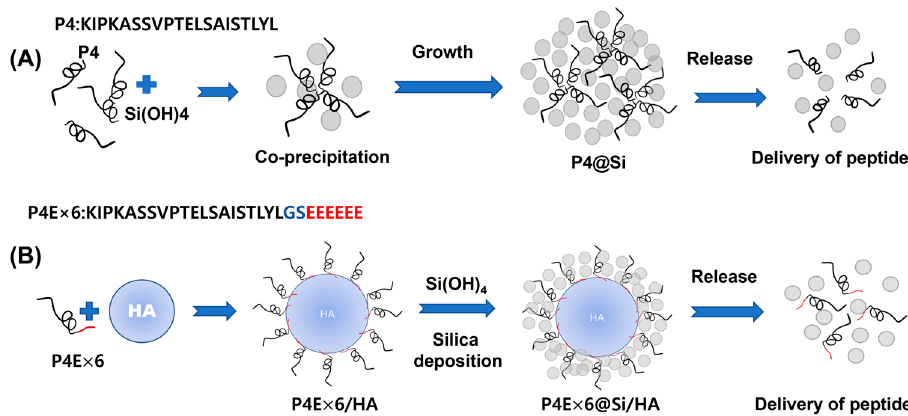
Scheme 1. Self-immobilization of P4 peptide via P4-mediated silica deposition and release